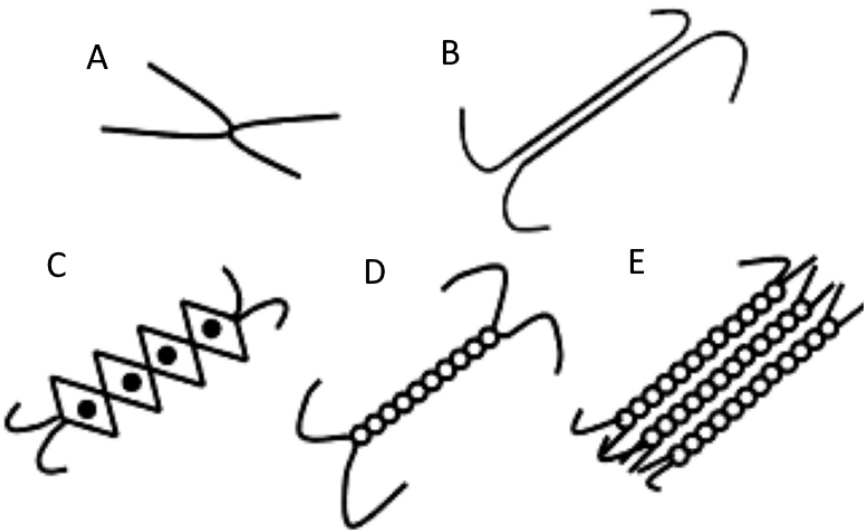
Figure 3. Different junction zones in polysaccharide gels: ( A ) connecting points, ( B ) extended junction zone resembling a block, ( C ) model of crosslinks in alginate and pectin gels based on an egg-box structure, ( D ) the region of the double-helix junction, and ( E ) junction zone for the aggregation of polysaccharide chains. Figure 3 is reprinted with permission from Nazir et al. [8] (Copyright © 2017 Elsevier Ltd., Amsterdam, the Netherlands).